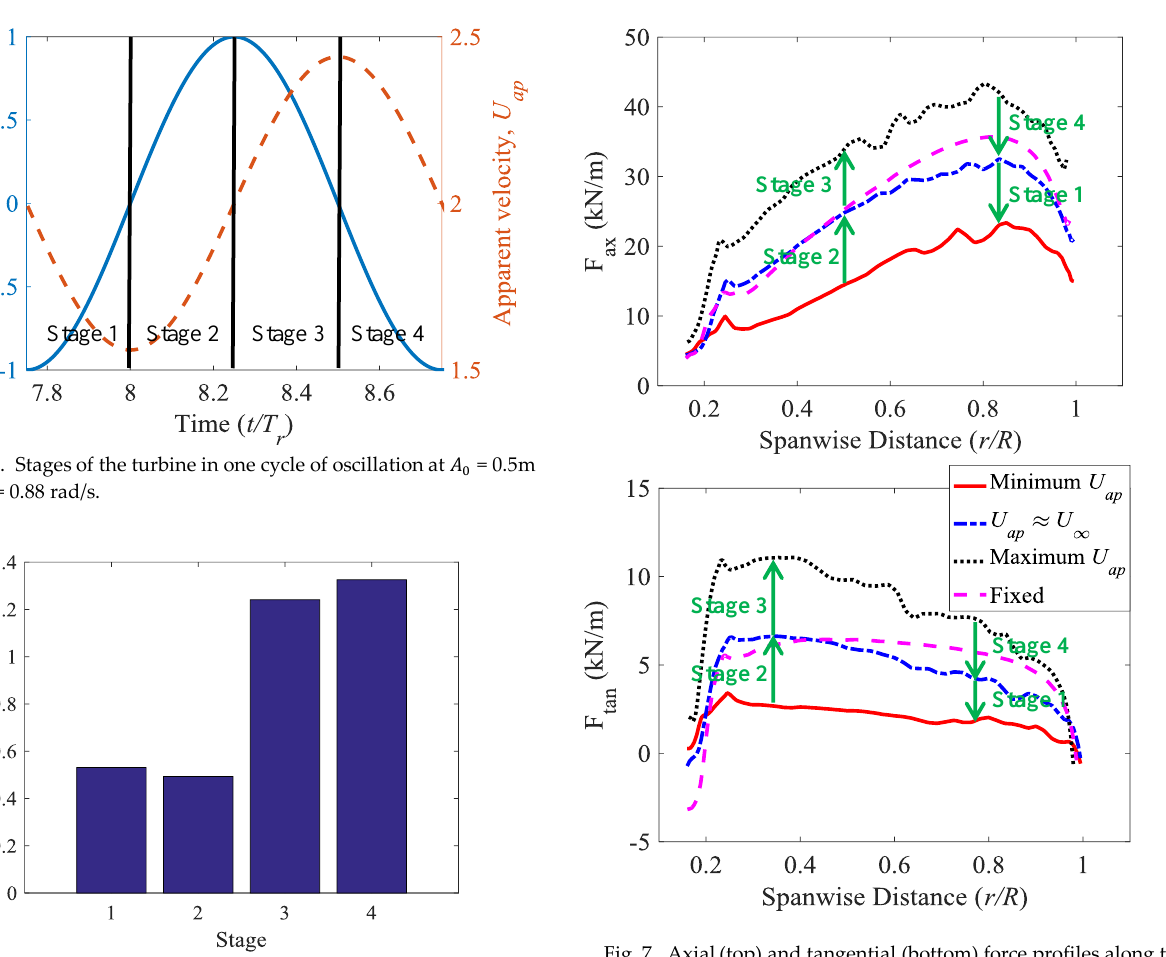
Fig. 7. Axial (top) and tangential (bottom) force profiles along the blade for fixed and surging turbines at three time steps which correspond to the minimum 𝑈 𝑎𝑝 , 𝑈 𝑎𝑝 ≈ 𝑈 ∞ , and maximum 𝑈 𝑎𝑝 . Fig. 7 shows the axial and tangential forces along the blade for the surging and fixed turbine cases. Loading on the blade increases and decreases with 𝑈 𝑎𝑝 for the surging turbine case. Three points in the cycle are considered; when 𝑥 𝐴 0 ⁄ = 0 and the turbine is advancing, leading to maximum 𝑈 𝑎𝑝 , when the turbine is at 𝑥 𝐴 0 ⁄ ≈ -1 and ⁄ = 0 and the turbine is 𝑈 ≈ 𝑈 𝑥 𝐴 𝑎𝑝 ∞ , and when 0 retreating, leading to minimum 𝑈 𝑎𝑝 . We observe that the spanwise force profiles of the surging turbine when 𝑈 𝑎𝑝 ≈ 𝑈 ∞ are not the same as those for the fixed turbine, demonstrating that there are dynamic effects associated with the acceleration and deceleration of the surging turbine. Such effects are not apparent when using a quasi- steady simulation methods such as Blade Element Momentum (BEM) theory. References [15], [16] make comparisons between BEM and CFD models, showing that one reason BEM under predicts the power and thrust variations is because the annular independence assumption in BEM does not all consideration of radial flow along the blade. Furthermore, wake expansion and contraction are not modelled in BEM, which renders the model unable to capture the unsteady wake dynamics effects, reducing